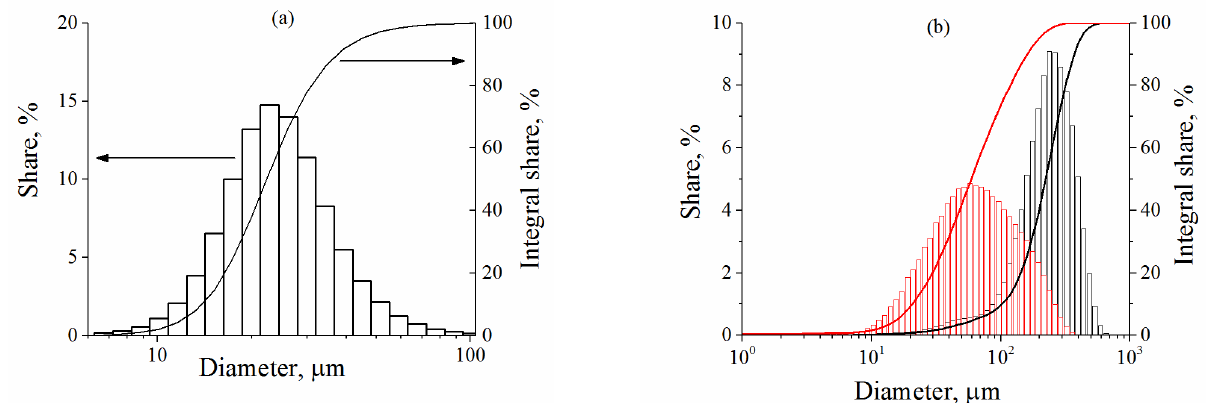
Figure 2. The particle size distribution diagrams of aluminum powders: PAD-1 ( a ) and high-purity aluminum powders ( b ), red lines relate to powder with an average diameter of 58 μ m, black ones—225 μ m).